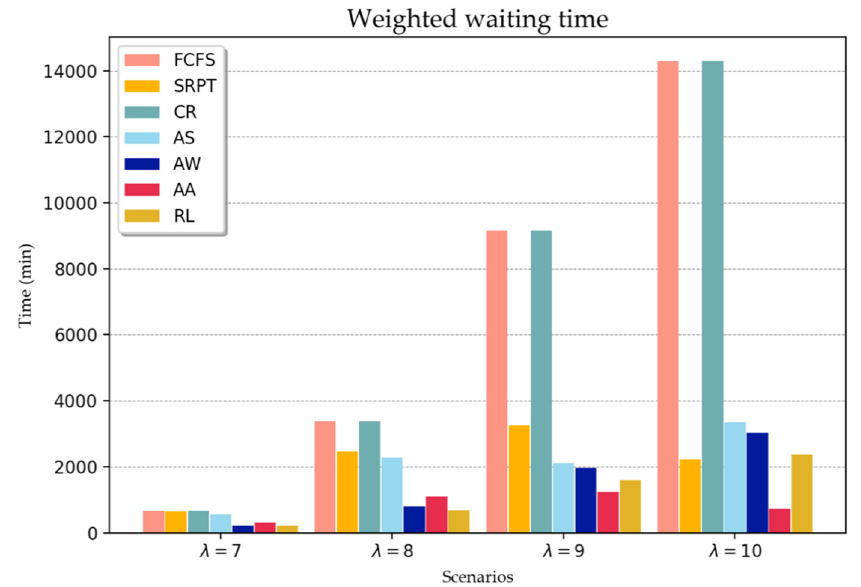
Figure 3. Comparison between conventional dispatching rules and those using RL.